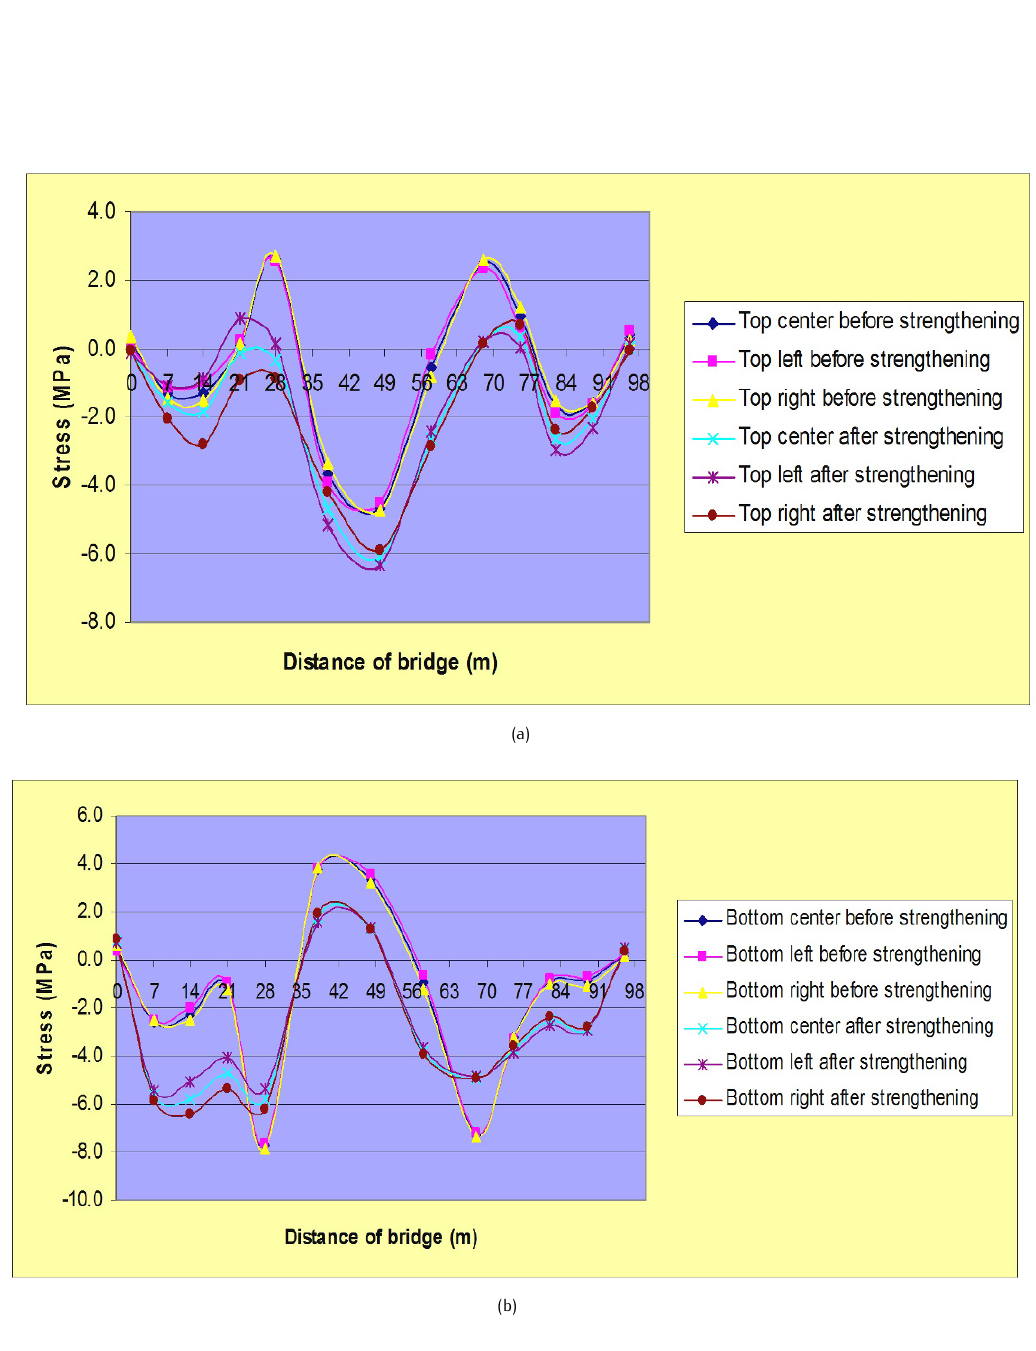
Figure 12. The values of stresses before and after strengthening due to load combination II for object No.1, (a) Max. top value of box girder, (b) Max. bottom value of box girder